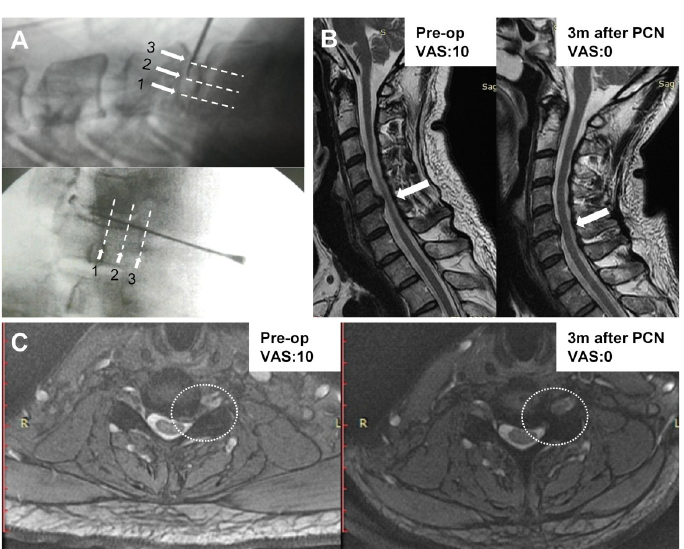
Fig 4. Radiographic and magnetic resonance images from a sample patient. (A) Representative intraoperative images showing the three-point circular coblation technique of PCN. The white arrows and dotted lines indicate the sequence and the target locations for the coblations performed in the target disc. Pre- and post- operative images of sagittal (B) and axial (C) T2-weighted MRI from a 48-year-old patient with C5-6 disc protrusion. The white arrows/ circle indicate the improvement of the entrapped left C5/6 nerve root due to